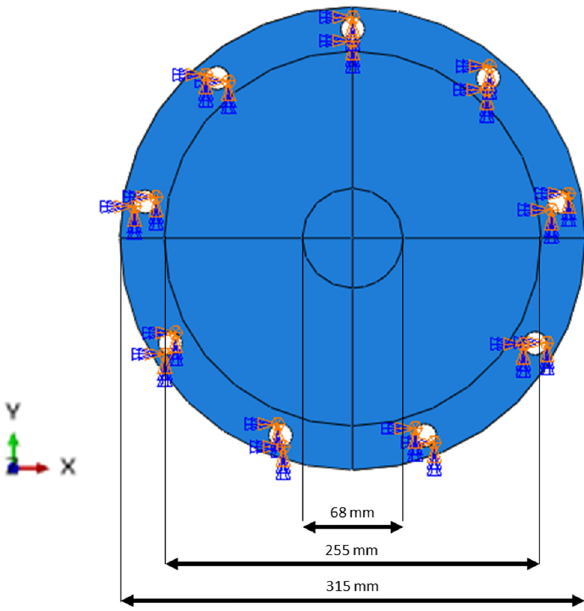
Figure 7: Boundary conditions model in ABAQUS/CAE.